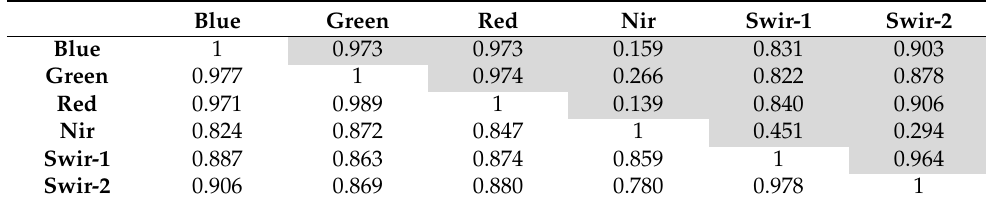
Table 1. The correlation coefficient matrix between each band (the shaded part is the result of masking non-rice pixels).